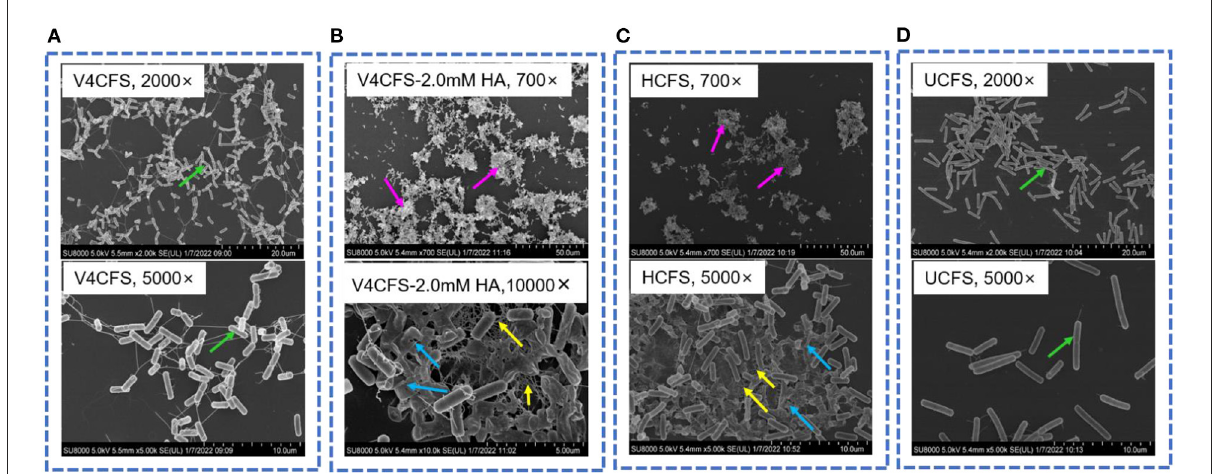
FIGURE4 Morphology of B. velezensis V4 under different culture conditions. Cell morphology of B. velezensis V4 in V4CFS ( A , 2,000 × and 5,000 × ), V4CFS-2.0mM HA ( B , 700 × and 10,000 × ), HCFS ( C , 700 × and 5,000 × ), UCFS ( D , 2,000 × and 5,000 × ) at 180min. Green arrows indicate normal morphology of cells with flagellum, purple arrows indicate cell aggregation, blue arrows indicate cell lysis and cellular debris, and yellow arrows indicate biofilm analogs.